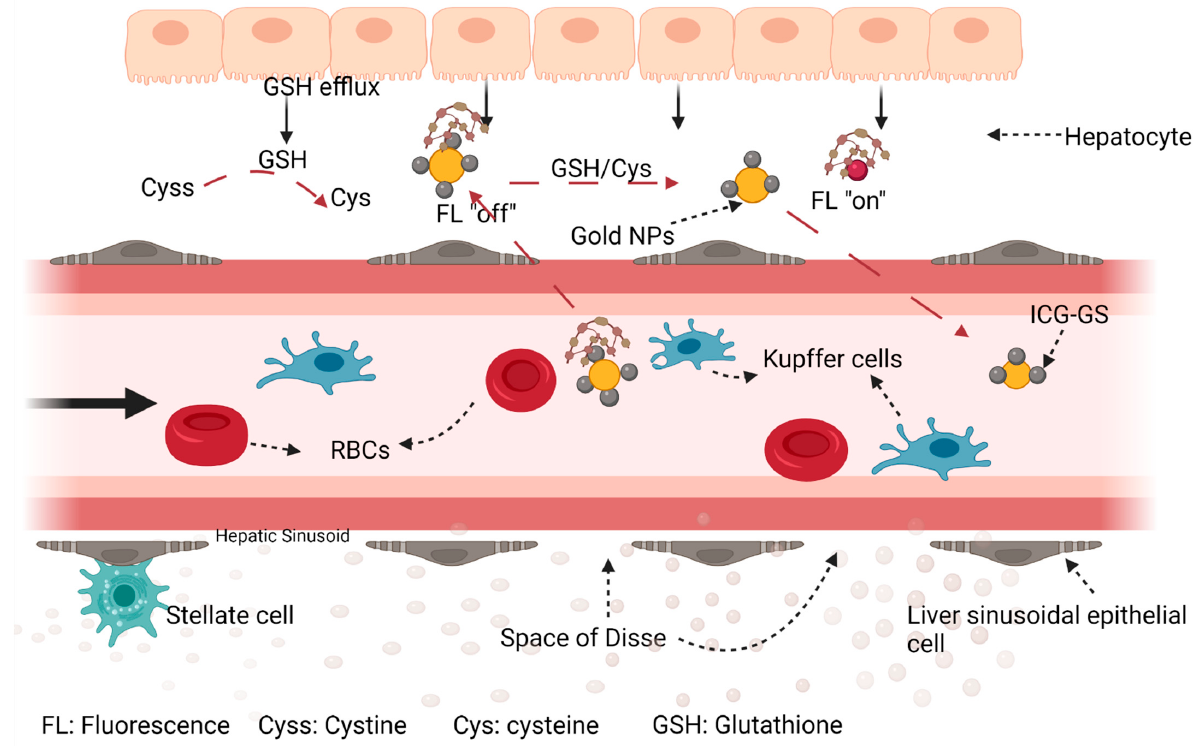
Figure 7. GSH secreted from hepatocytes converts extracellular cystine (Cyss) to cysteine (Cys), which together with GSH, undergo disulfide bond interaction with ICG 4 -GS-Au25 conjugates thereby displacing protein bound ICG-GS from the surface of gold nanoparticles (Au25). The displaced ICG-GS (whose fluorescence was suppressed while bound to gold nanoparticles) regains fluorescence and become susceptible to renal clearance. After periods of residence within the body, enough time for a chance to extravasate into the tumor microenvironment, untransformed ICG 4 -GS-Au25 is eventually broken down and eliminated. Modified from (Ref. [115]) and created with